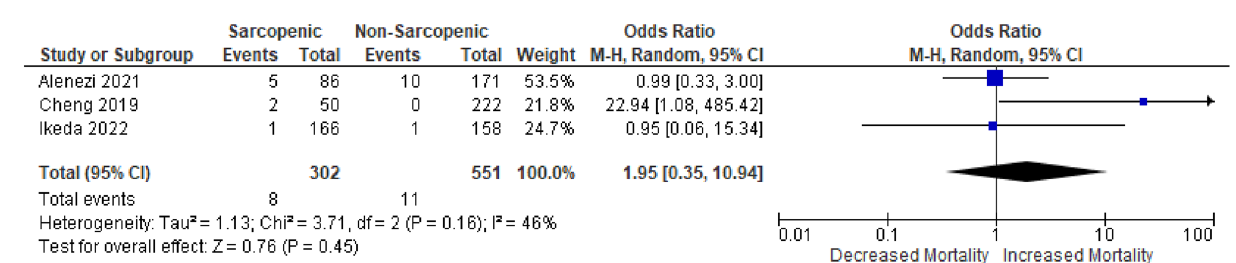
Figure 2. Forest Plot of the risk of post-operative mortality in sarcopenic vs. non-sarcopenic patients undergoing EVAR and F/B-EVAR for each of the included studies. Plots to the right of the X-axis represent an increased risk of mortality in sarcopenic patients.